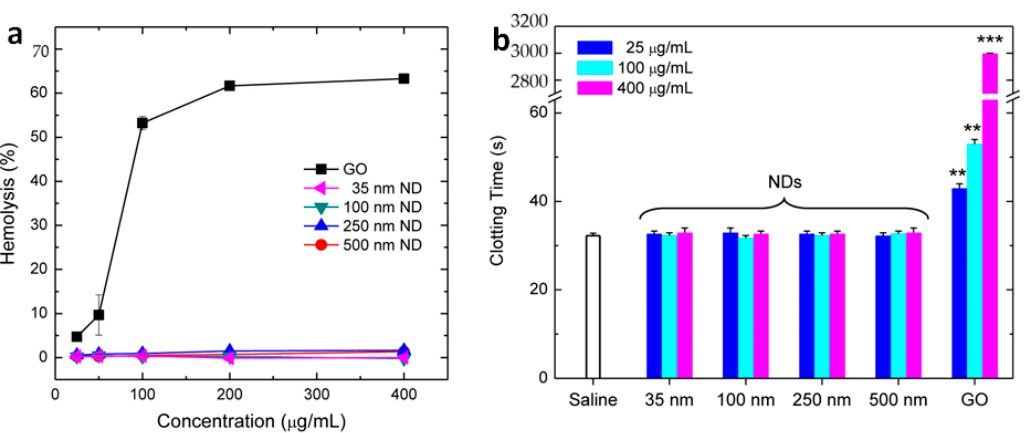
Figure 3. ( a ) Hemolysis percentages measured by exposition of RBCs to ND (35, 100, 250, and 500 nm in diameter) and graphene oxide (GO) samples at the concentration range of 25–400 µ g / mL. Reproduced with permission from [83]. ( b ) Activated partial thromboplastin time (aPTT) assays of GOs and oxidized NDs of di ff erent size using human serum. ** p < 0.01 and *** p < 0.001 Reproduced with permission from [83]. NDs showed significantly lower hemolysis respect to GO and values comparable to saline negative control for the